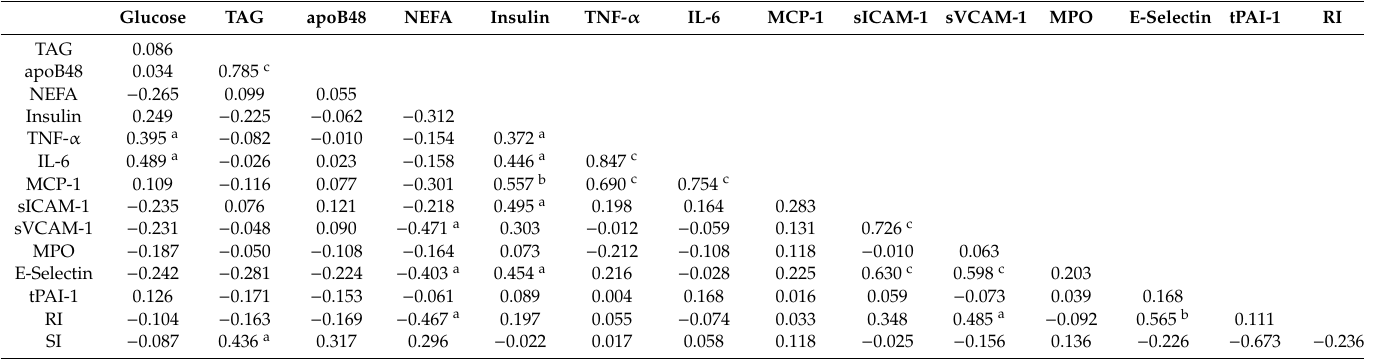
Table 2. Spearman correlation coe ffi cients between plasma clinical laboratory parameters at baseline.